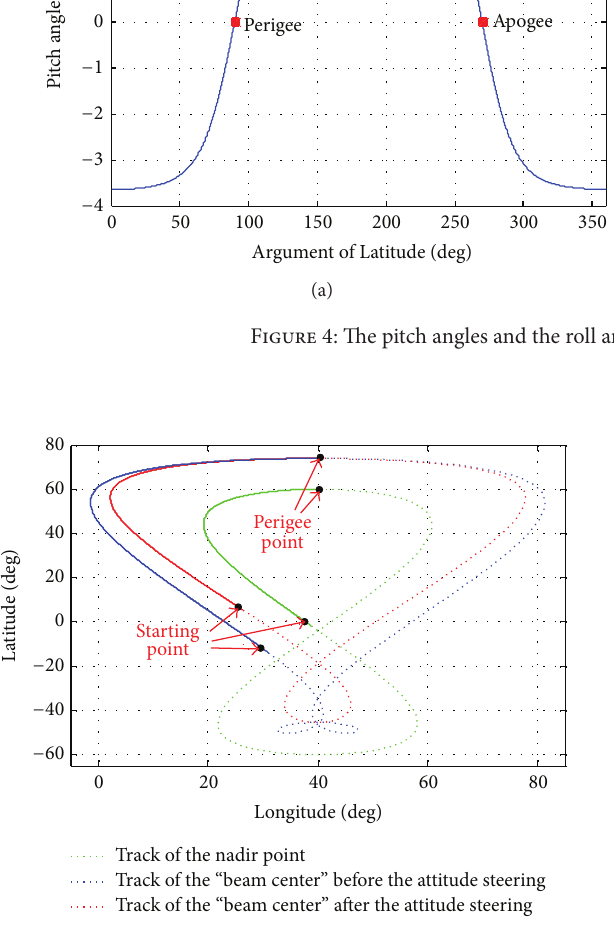
Figure5:Comparisonsofthetrackofthenadirpointandtwotracks of the BCP before and after the attitude